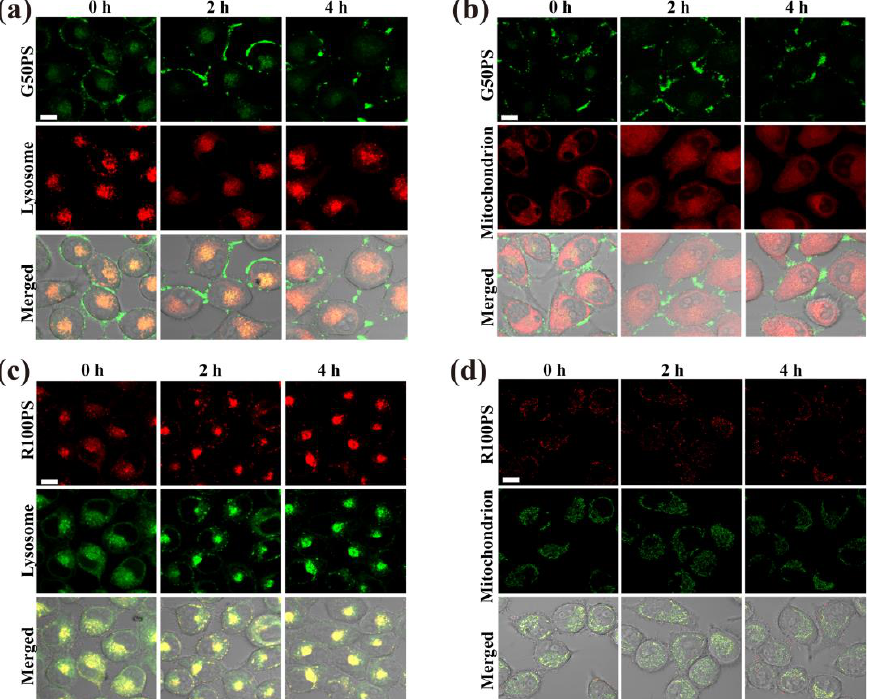
Figure 9. CLSM images of PS NPs in lysosomes ( a , c ) and mitochondrion ( b , d ) during exocytosis in A549 cells. Cells were pre-incubated with 20 µ g/mL G50PS ( a , b ) and R100PS ( c , d ) for 4 h and then incubated in fresh culture medium for 0, 2, and 4 h. The scales represent 10 µ m.